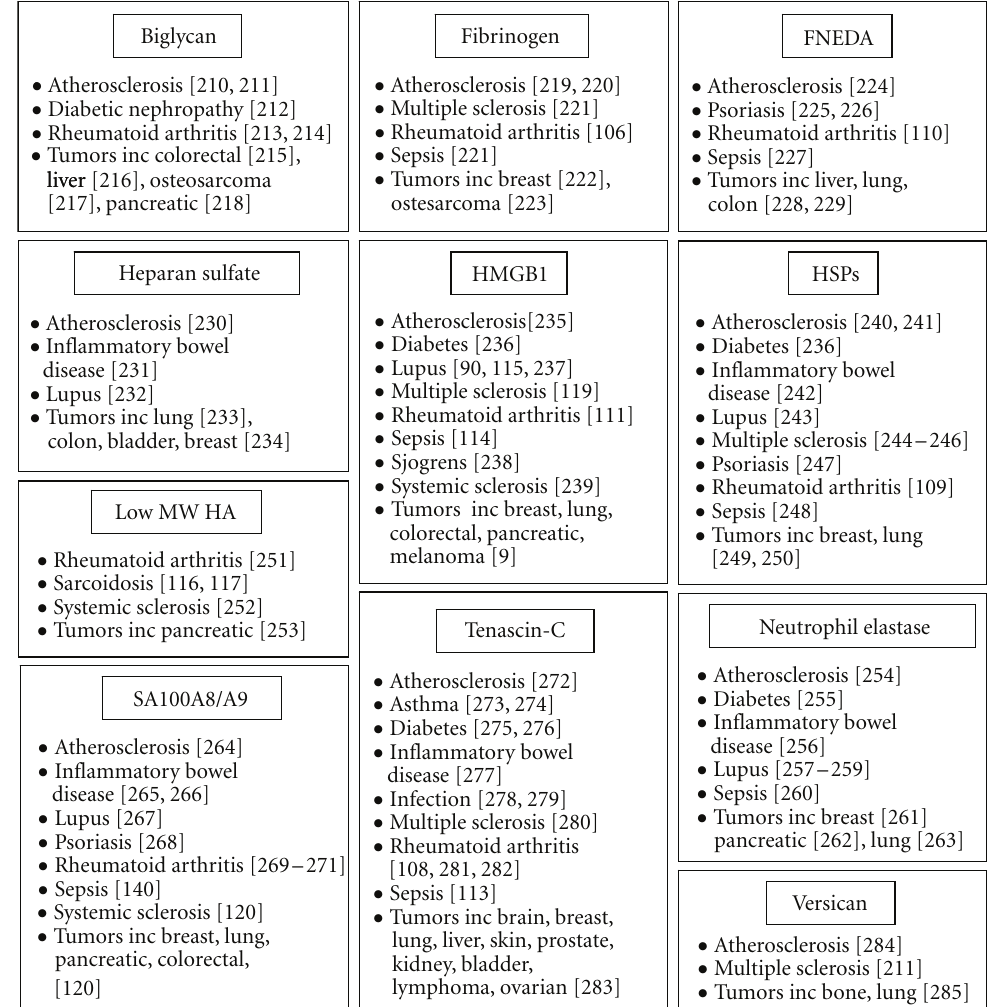
Figure 3: DAMPs and human disease . High levels of many DAMPs are associated with a wide variety of inflammatory and autoimmune diseases as well as with atherosclerosis and